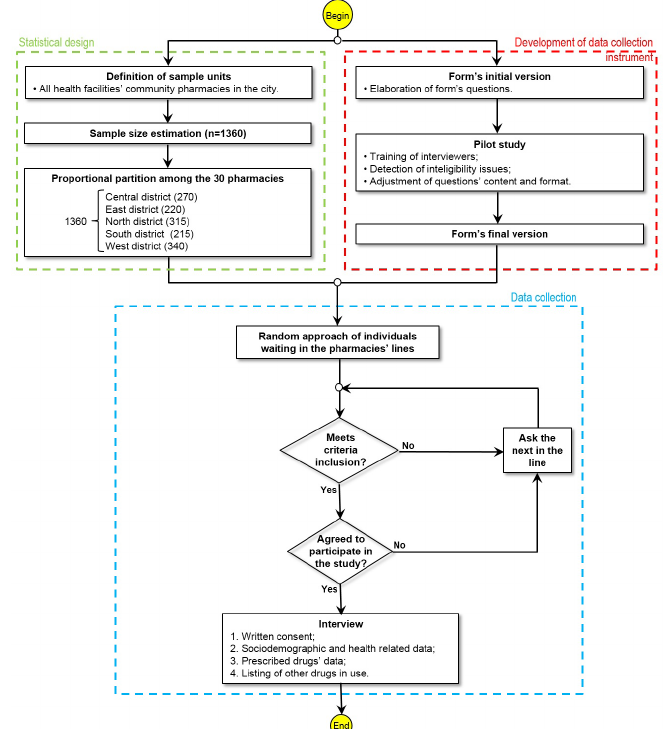
FIGURE 1 - Study operation flowchart, December